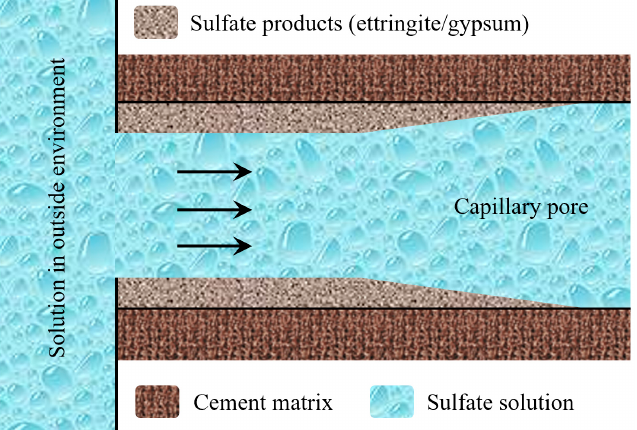
Figure 4. Filling of sulfate products in pore [70].